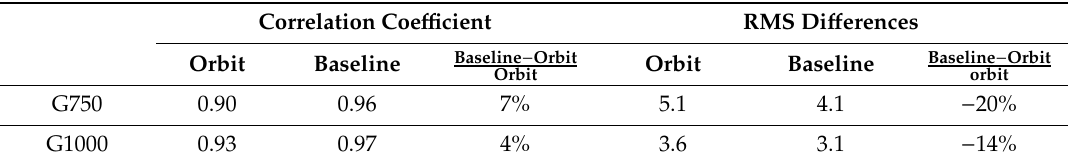
Table 4. Correlation coe ffi cients and RMS di ff erences (cm) between mass anomaly time series over the Amazon river basin inferred from the GPS-based solutions and WHU RL01.